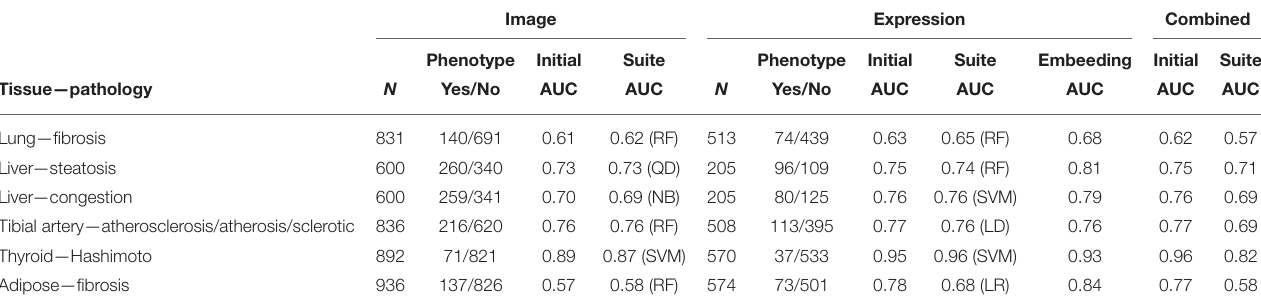
TABLE 1 | Summaries of predictive performance for histopathology-derived phenotypes from imaging data, gene expression data, and integrative